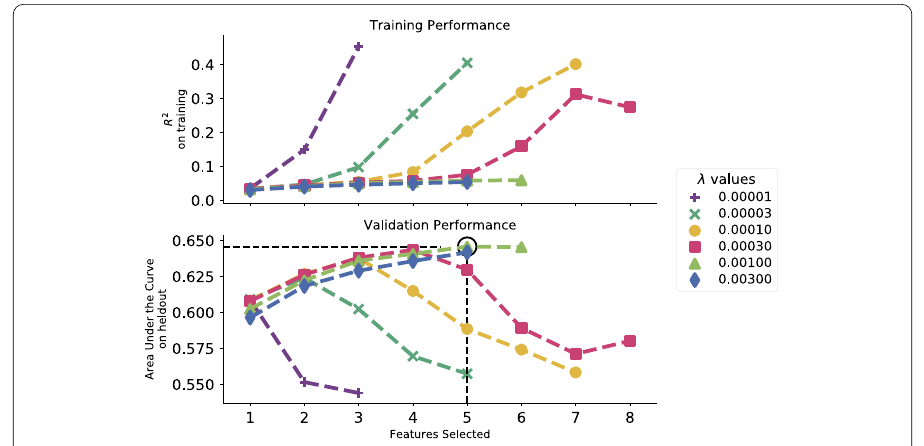
Figure 2 Hyperparameter tuning on StackExchange data. Top: R 2 in the training set as a function of λ and k ; Bottom: AUC on the held-out data. Note that for illustration, we show the trajectory for only one of five splits. Different “best” hyperparameters may exist for different